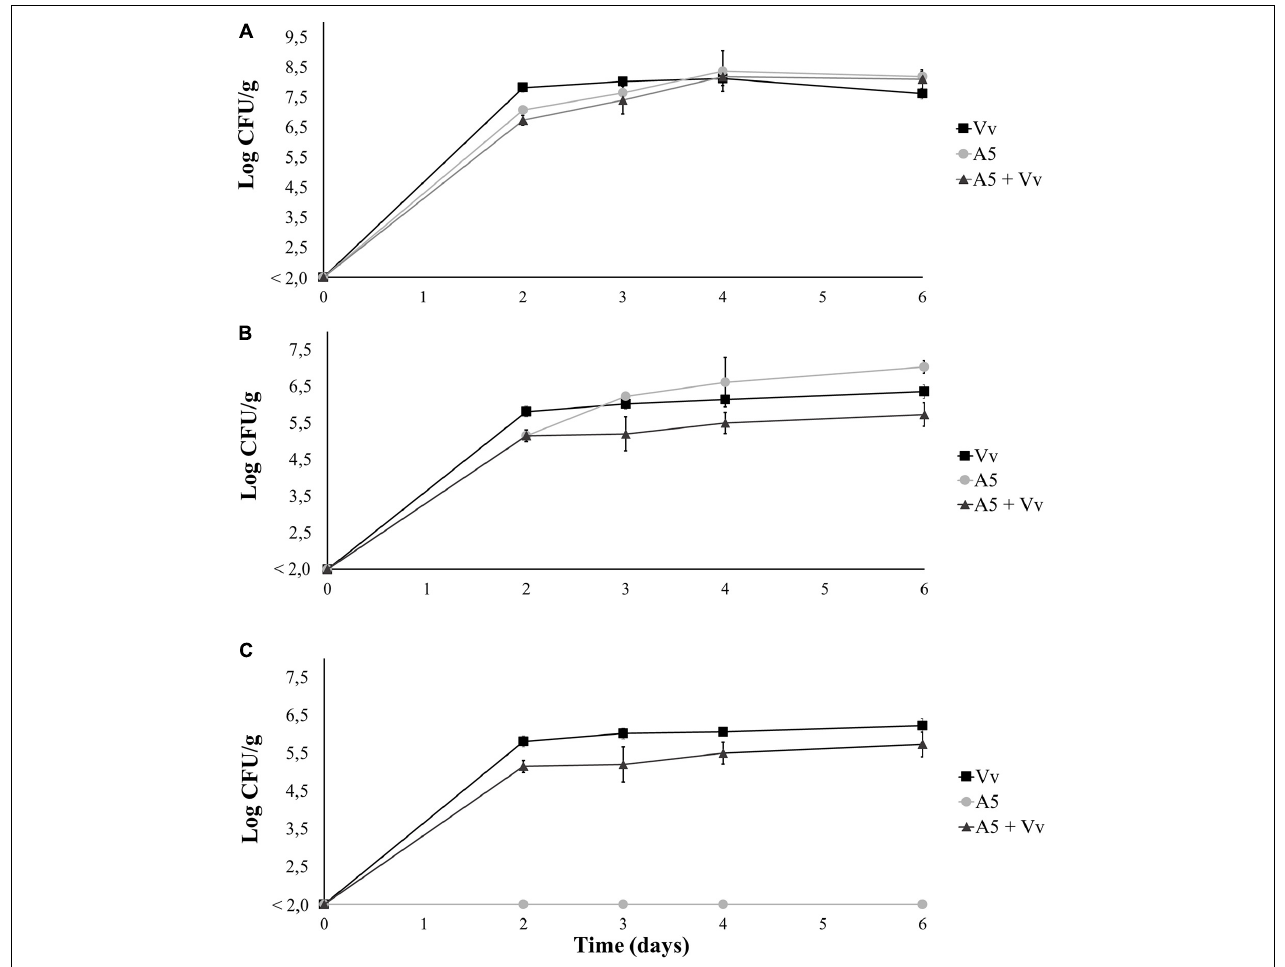
FIGURE 2 | Total aerobic bacteria (A) , total vibrio (B) , and Vibrio vulnificus (C) levels in coculture experiments in autoclaved oysters. Oysters from the Vv treatment were inoculated with V. vulnificus only ( (cid:4) ), oysters from the A5 treatment were inoculated with A5 only ( • ), oysters from the A5 + Vv treatment were co-inoculated with A5 and V. vulnificus ( (cid:78) ). The absence of colonies is represented as below the limit of detection (LOD) of 2.0 log